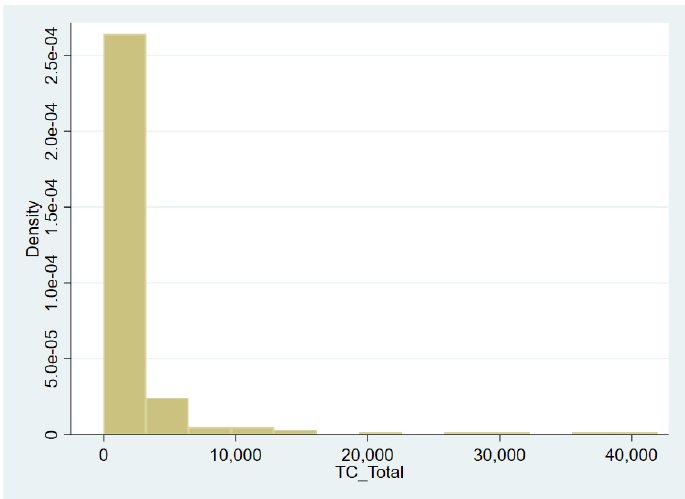
Figure 3. Numerical transaction costs in contracts (N =